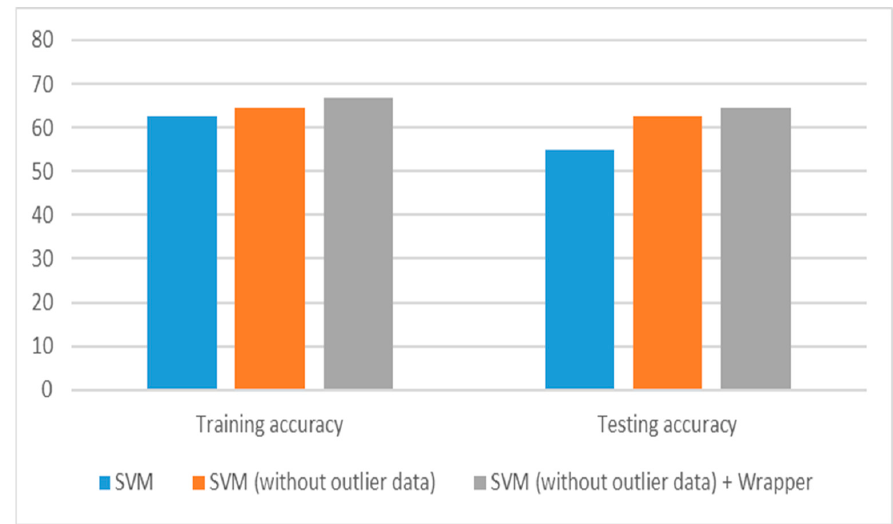
Figure 3. The classification accuracy of the SVM algorithm through the proposed system phases to predict the total deaths.